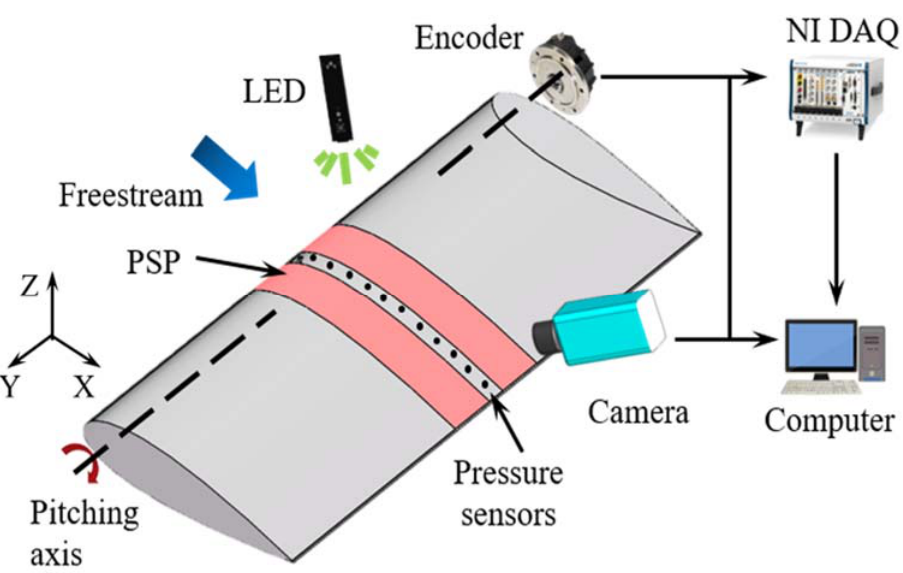
Figure 1. Schematic of a measurement system using pressure and PSP.